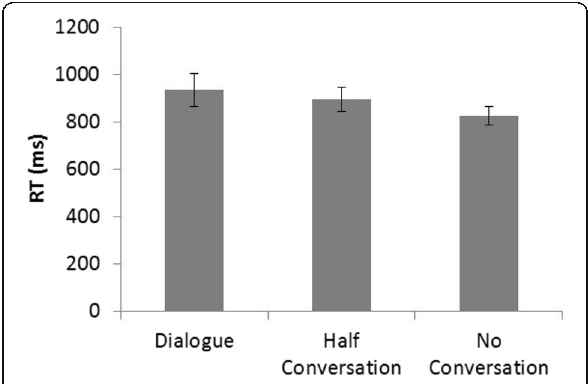
Fig. 10 Reaction times (RTs) for each condition in experiment 4. Error bars represent the standard error